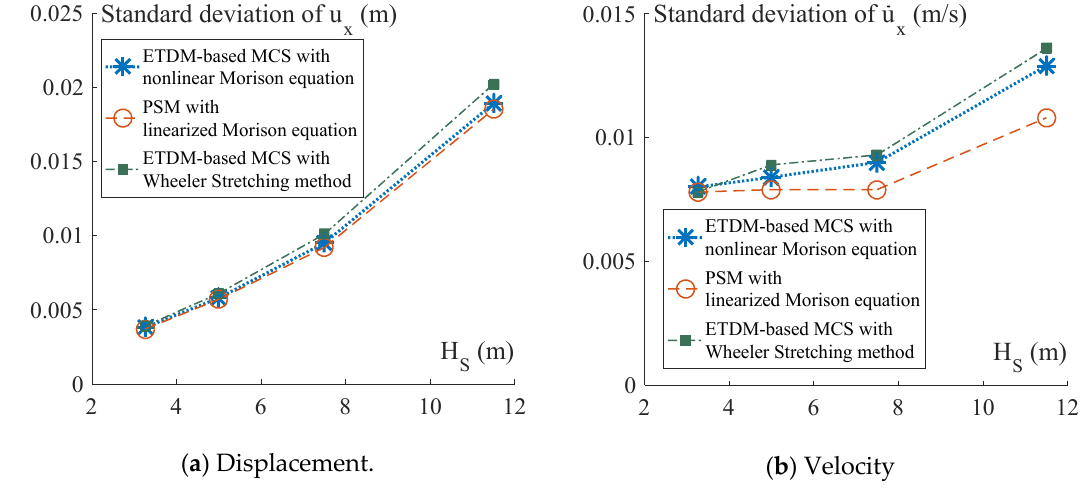
Figure 11. Standard deviations of the displacement and velocity at a top node of the jacket platform.